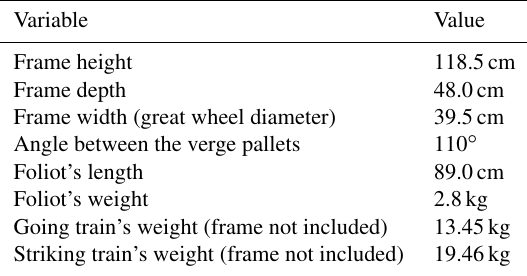
Table 2. Cotehele clock restoration model’s geometric and kine- matic